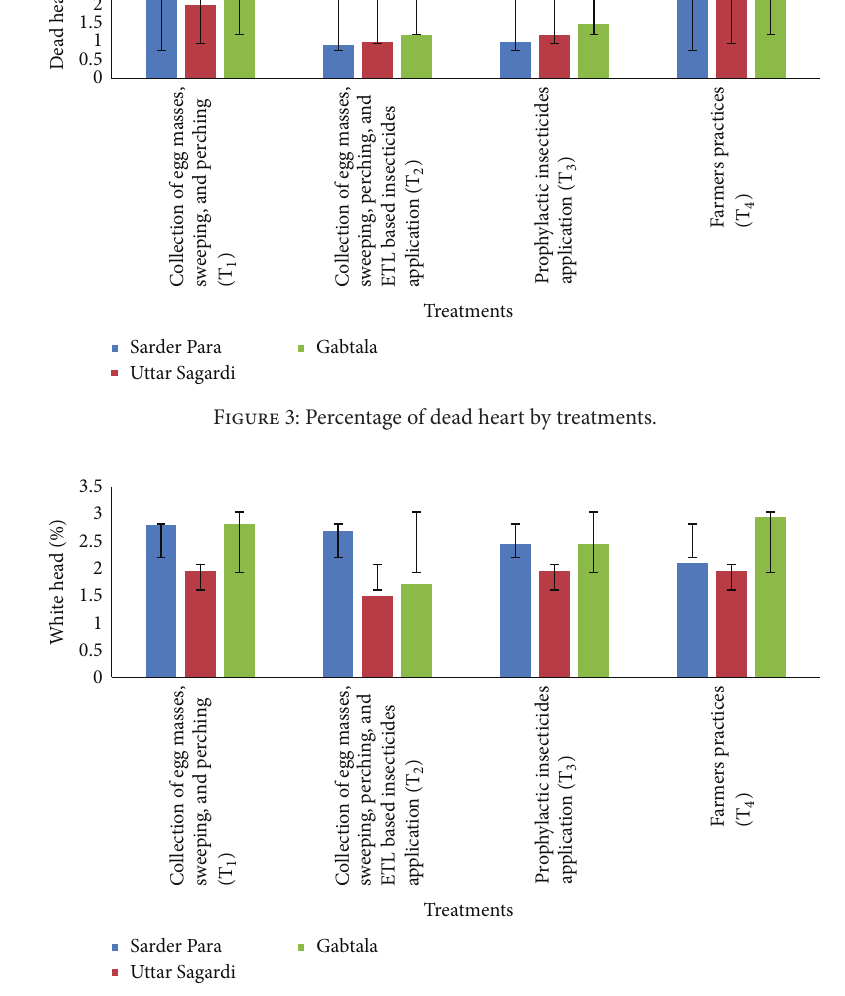
Figure 4: Percentage of white head by